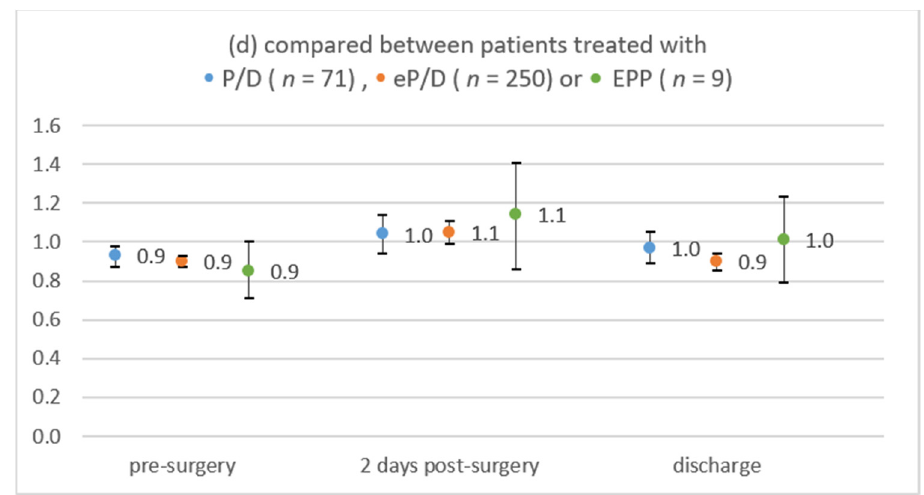
Figure 2. Creatinine values during the perioperative course: ( a ) over time, ( b ) low-dose versus high-dose of cisplatin, ( c ) cisplatin alone versus cisplatin plus doxorubicin, ( d ) depending on surgical cytoreduction. Statistical signifinance differences at * p ≤ 0.050, ** p ≤ 0.010, and *** p < 0.001.